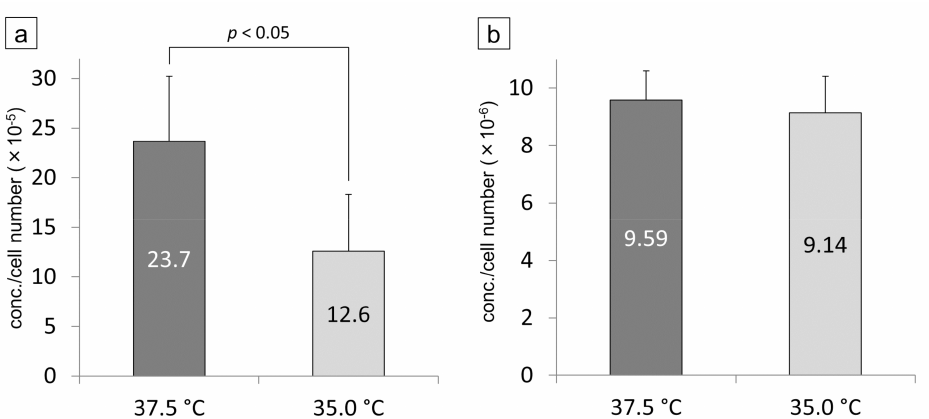
Figure 9. The proteins of A β 1-40 ( a ) and 1-42 ( b ) in the iHLEC-NY2 culture medium were measured by ELISA. The detected concentration was corrected by the number of cells. The protein concentration of A β 1-40 was significantly higher at 37.5 ◦ C than at 35.0 ◦ C ( p <